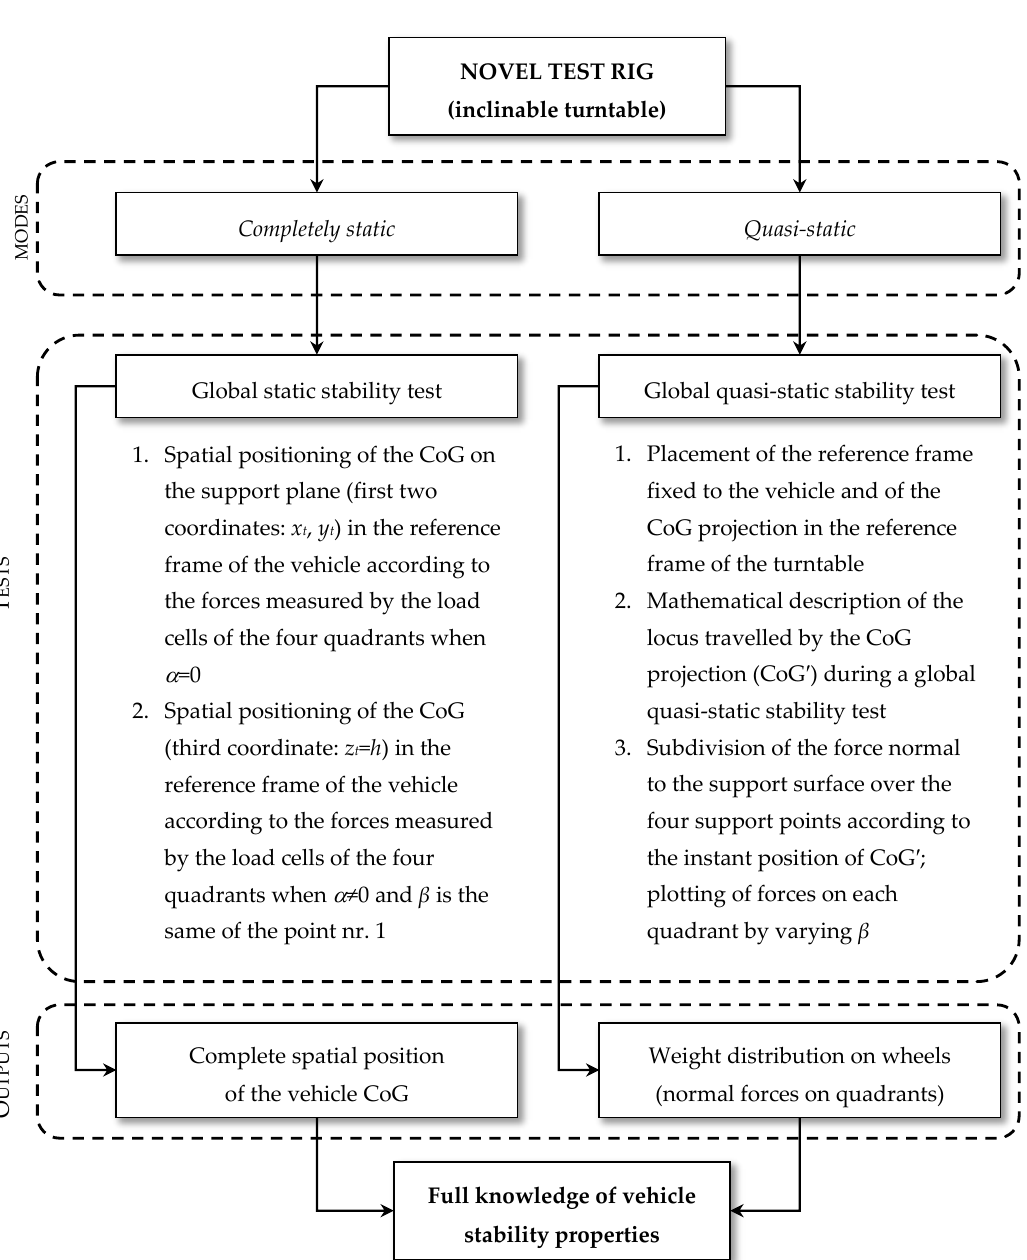
Figure 2. The approach followed in the prediction of experimental outputs in the two operative modes for the test rig illustrated in this paper.